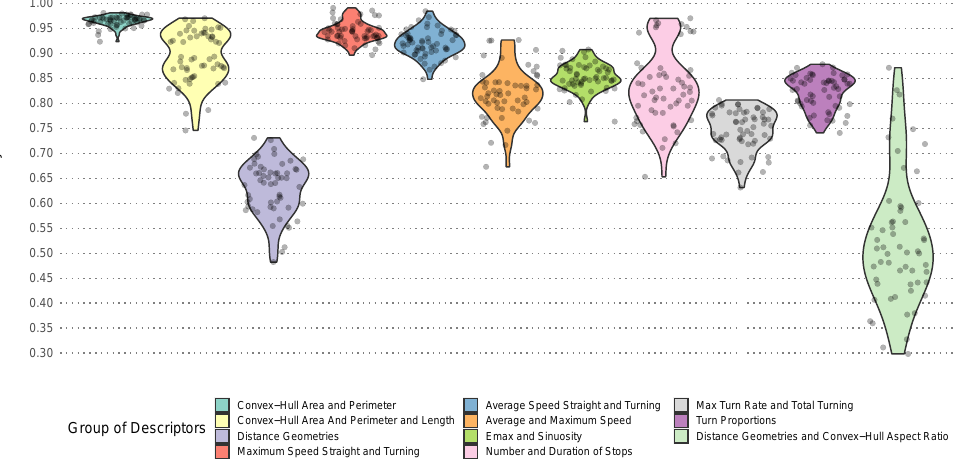
Figure 15. The verification of the conjecture regarding universal similarity. Each dot shows the aver- age strength of the similarity bonds between several groups of predictors for each of the 57